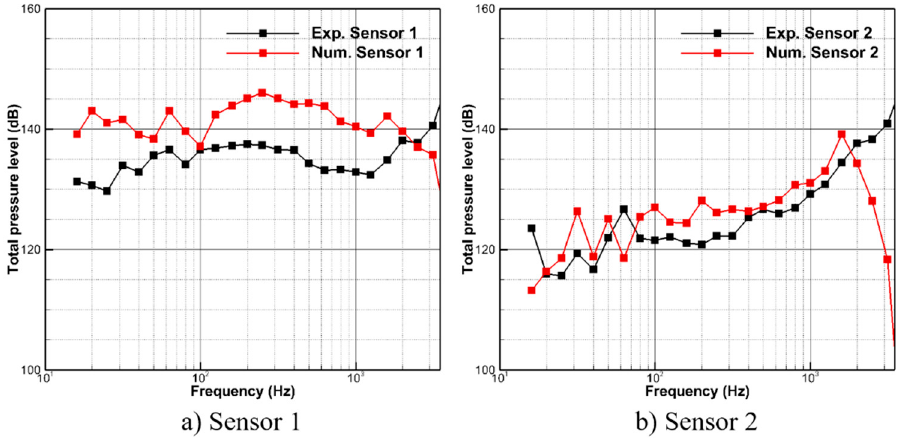
Figure 12. Total pressure level; ( a ) Sensor 1, ( b ) Sensor 2.